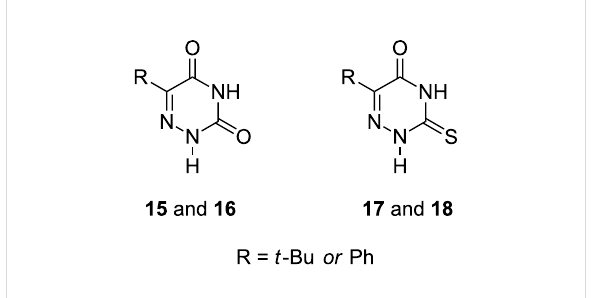
Figure 7: Structures of 6-azapyrimidines 15 – 18 tested for E. coli UP and